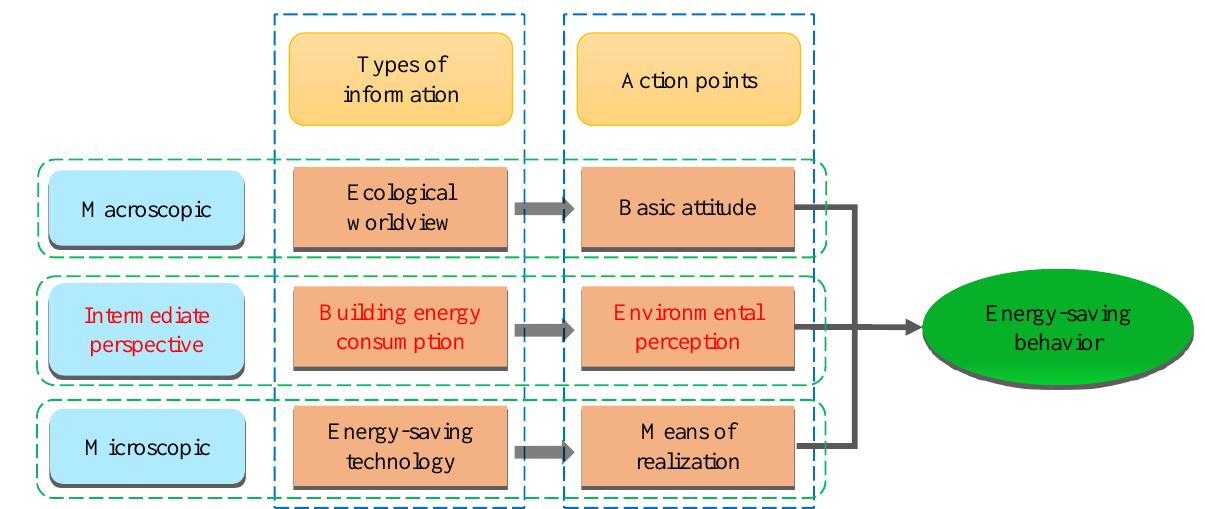
Figure 1. The connection and difference of the three types of information.